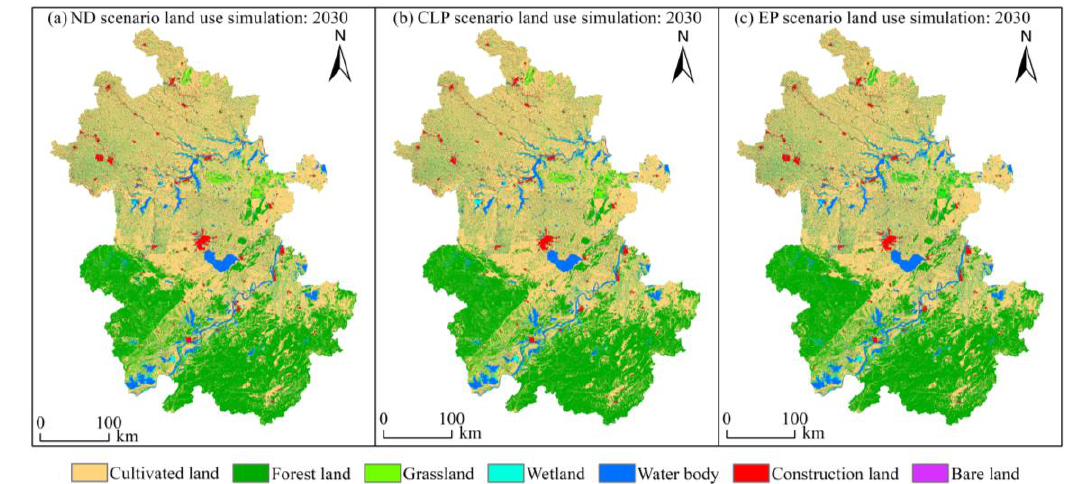
Figure 9. Results from the multi-scenario simulation for land use in 2030.